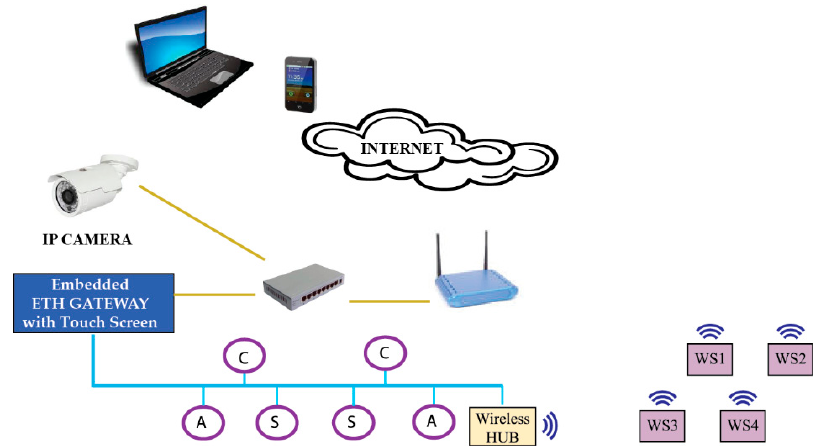
Figure 7. System architecture based on web services (C/S/A-controller/sensor/actuator nodes, WS1-4-wireless sensor nodes, Eth-Ethernet) (after [15]).